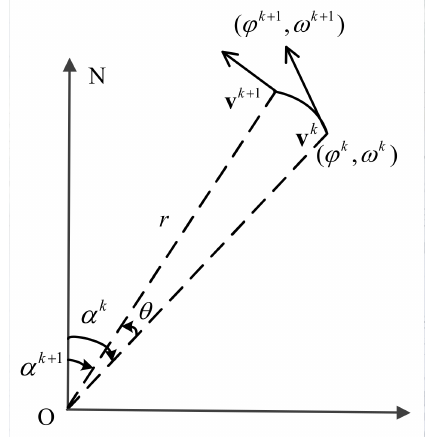
Figure 3. Geometrical model of turning